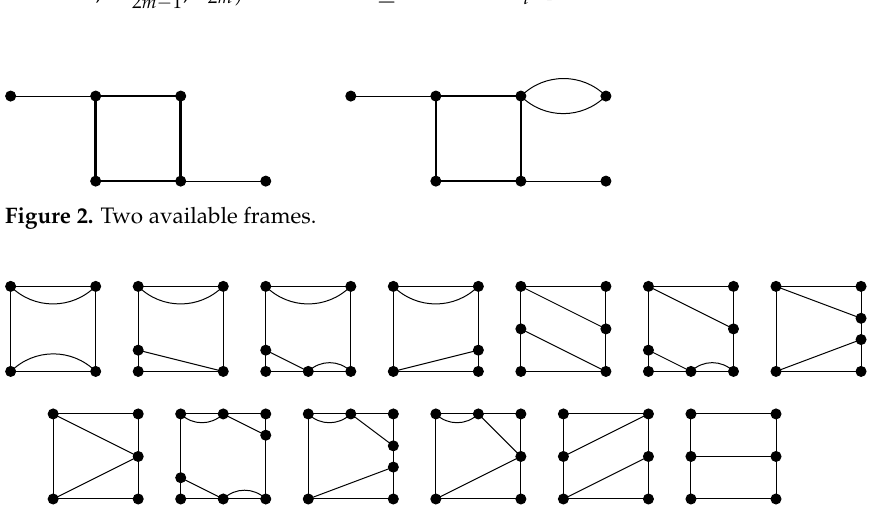
Figure 3. Thirteen available pictures to insert into a frame.